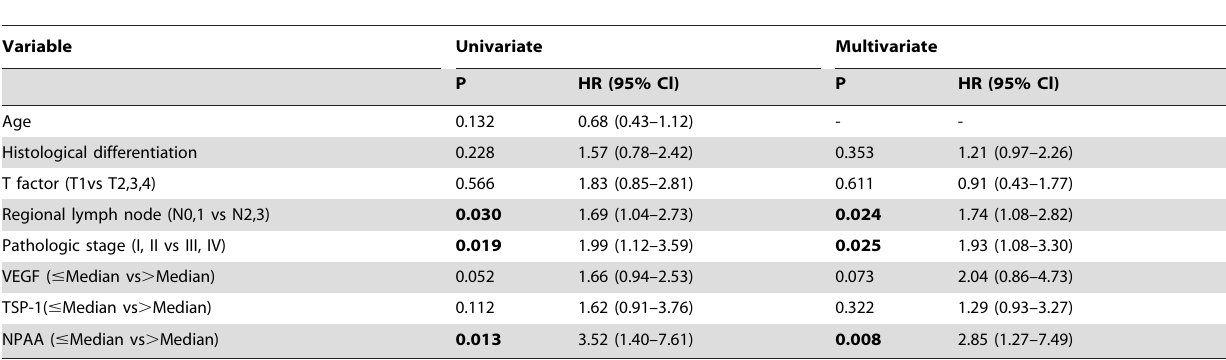
Table 4. Cox Regression Analysis for Disease-free Survival in 68 Patients with Lung Cancer.